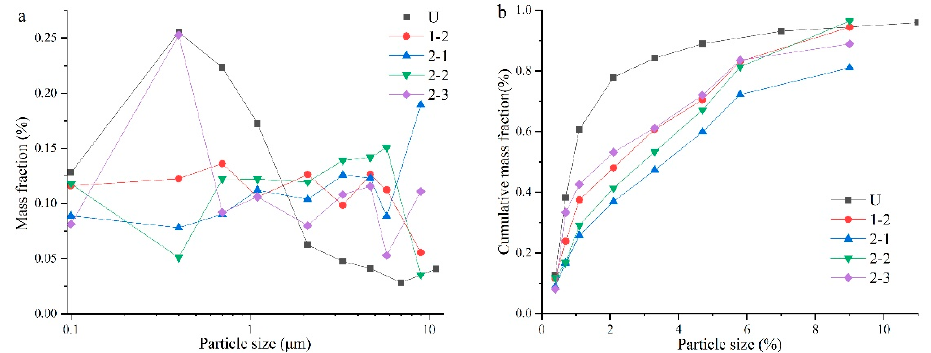
Figure 4. Comparison of distributions between Ce and U [21] “Adapted with permission from Ref. [Characterization of Uranium Oxide Aerosols]. 1994, Surya Narayana, D.S.” and Ce. ( a ): The fraction distribution of mass. ( b ) The fraction distribution of cumulative mass.